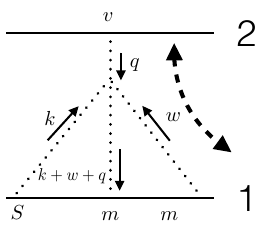
2 with the \peace/log" C , the C